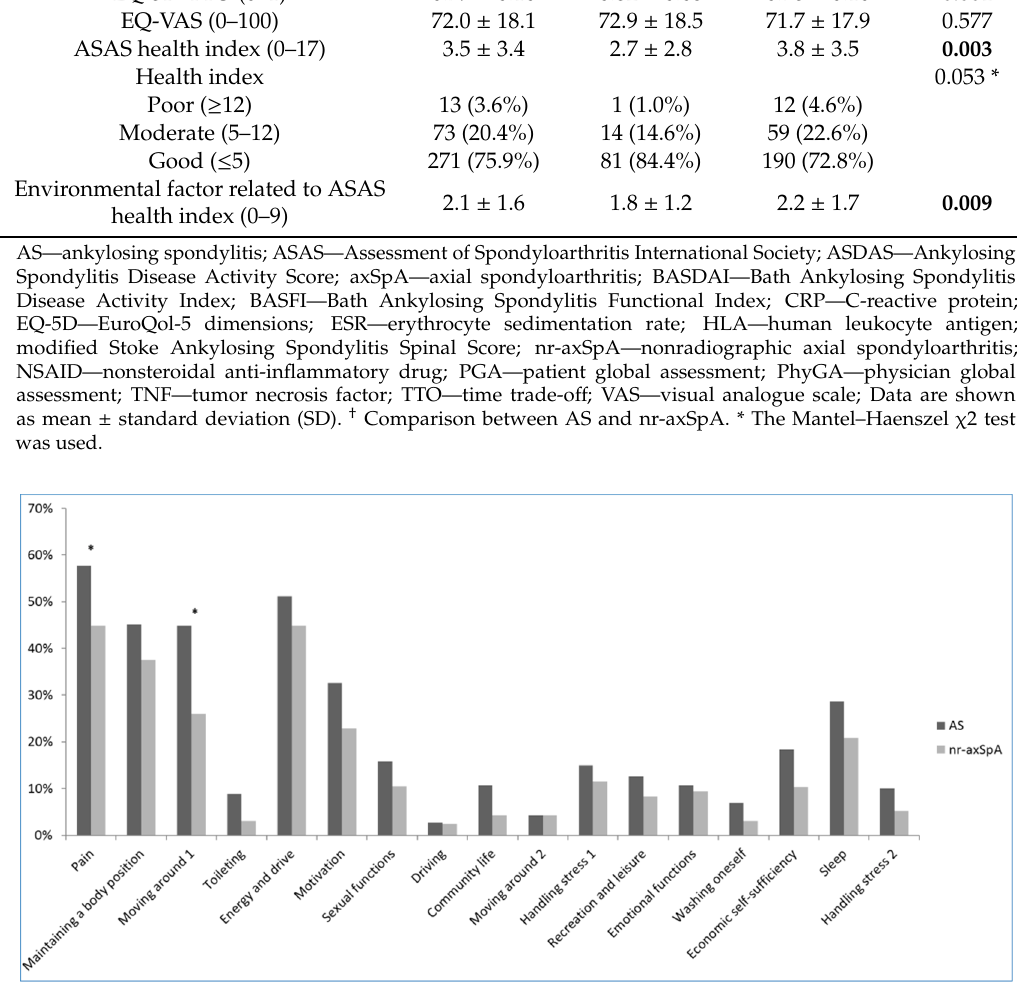
Table 3. Spearman correlation between ASAS HI scores and other patient-reported outcomes (PROs). Rho